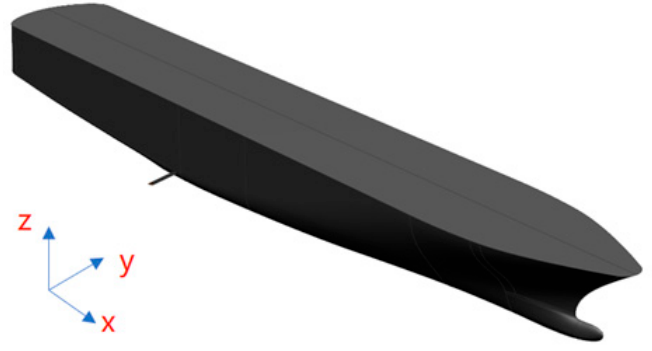
Figure 4. Ship model with a pair of fin stabilizers.